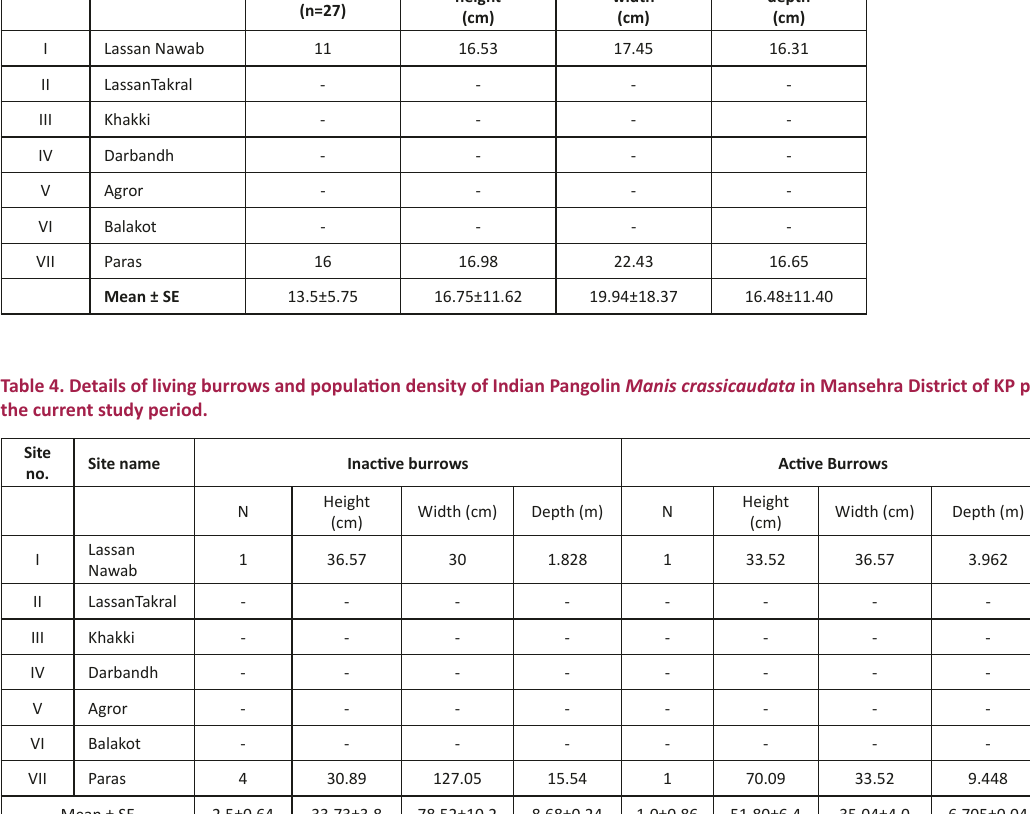
Table 3. Characteristics of feeding Burrows of Indian Pangolin Manis crassicaudata quantified at two positive sampling sites of Mansehra District during the study period. Site no.